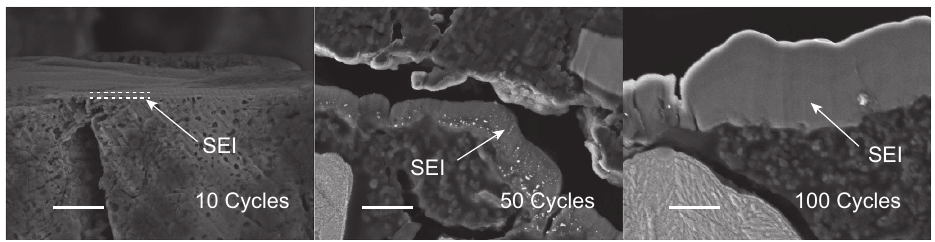
Figure 8 | Cross-sectional SEM images. Cross-sectional SEM images of the Li(V 0.5 Ti 0.5 )S 2 electrode collected at the end of the 10th, 50th and 100th cycles. Scale bar, 1 m m.